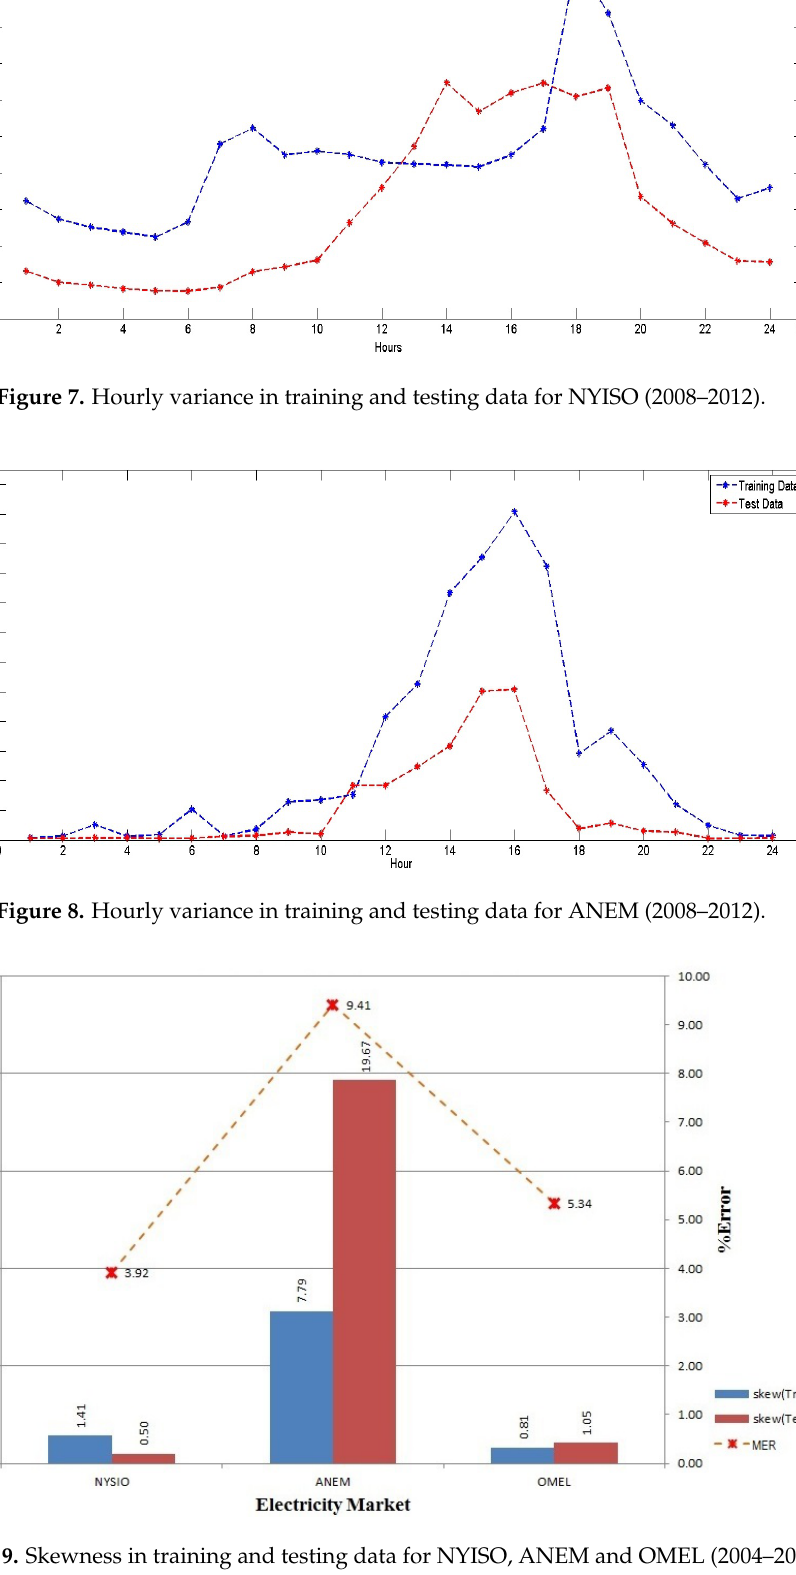
Figure 9. Skewness in training and testing data for NYISO, ANEM and OMEL